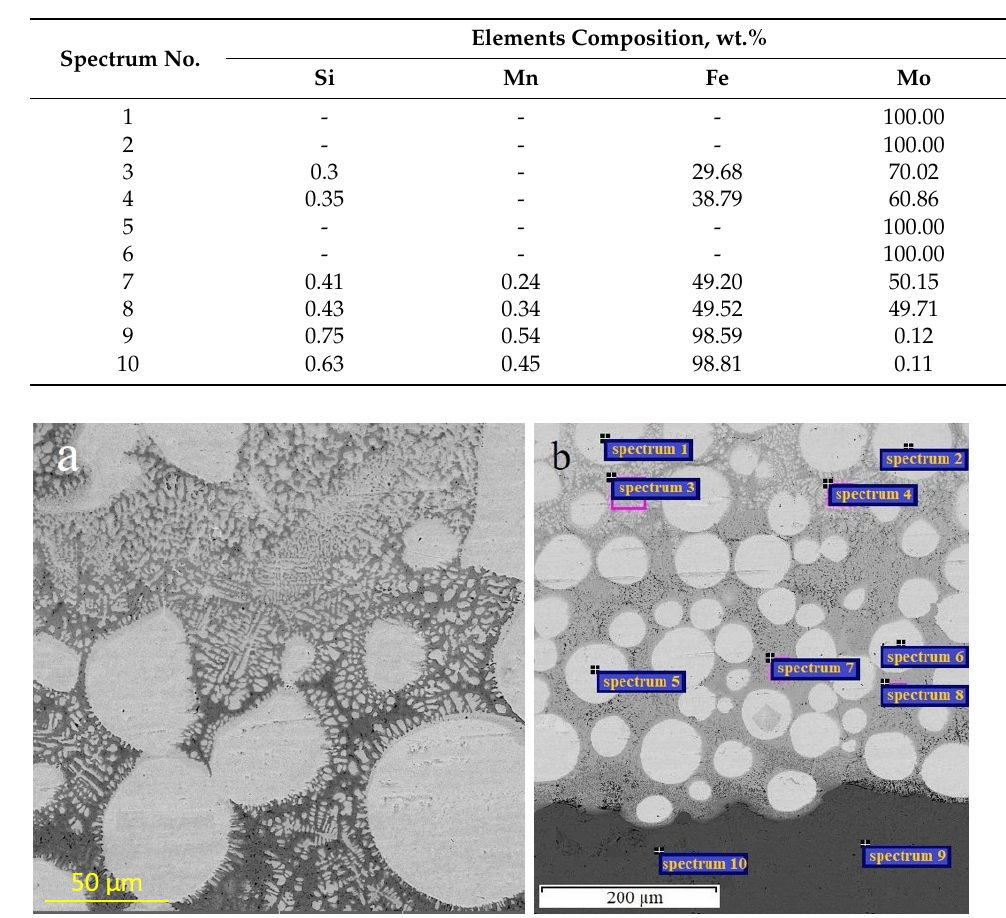
Figure 11. ( a ) Microstructure of the deposited Mo layer; ( b ) single EDX spectrum map. Table 6. Single EDX spectrum analysis in the Mo–steel boundary area (Figure 11b). Spectrum